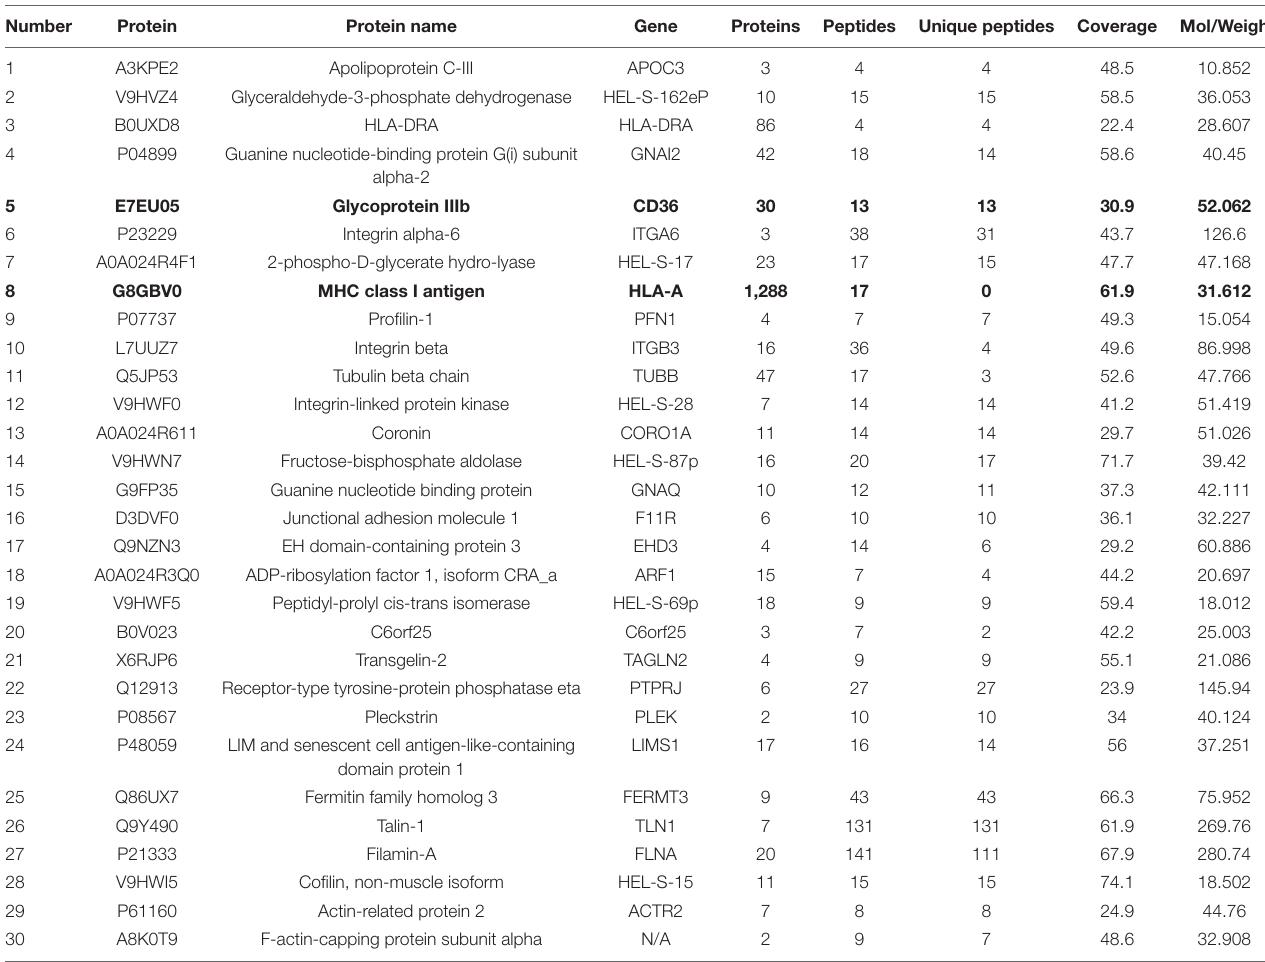
TABLE 3 | List of 30 down-expressed proteins with significant interesting in exosomes from ATB patients. Number